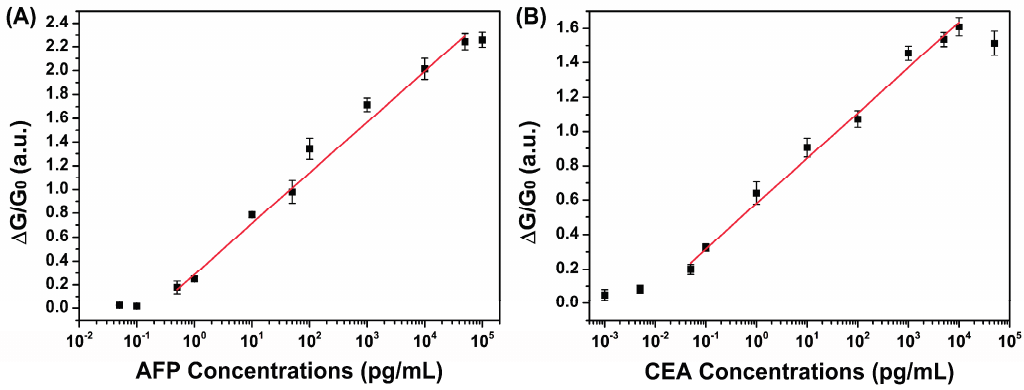
Figure 7. Calibration curves for the response of the fabricated biosensor to AFP ( A ) and CEA ( B